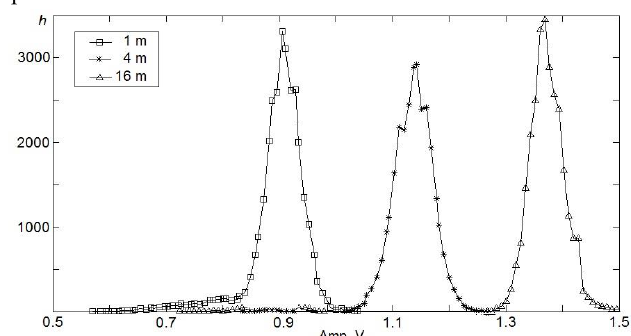
Fig. 1. Distribution of amplitudes Amp of the envelope of chaotic radio pulses in the receiver at various distances d between the emitter and the receiver. Squares – 1 m, stars – 4 m, triangles – 16